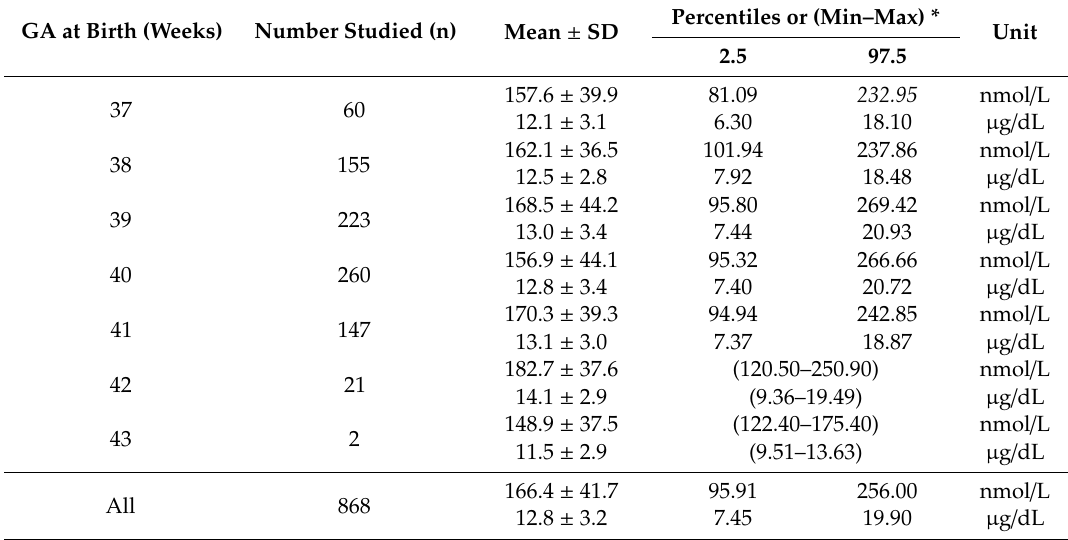
Figure 4. Boxplot of tT 4 concentrations (nmol/L) in dried blood samples (DBSs) of term-born infants. Circles represent outliers. Table 4. Mean concentration of tT 4 and percentiles according to gestational age.